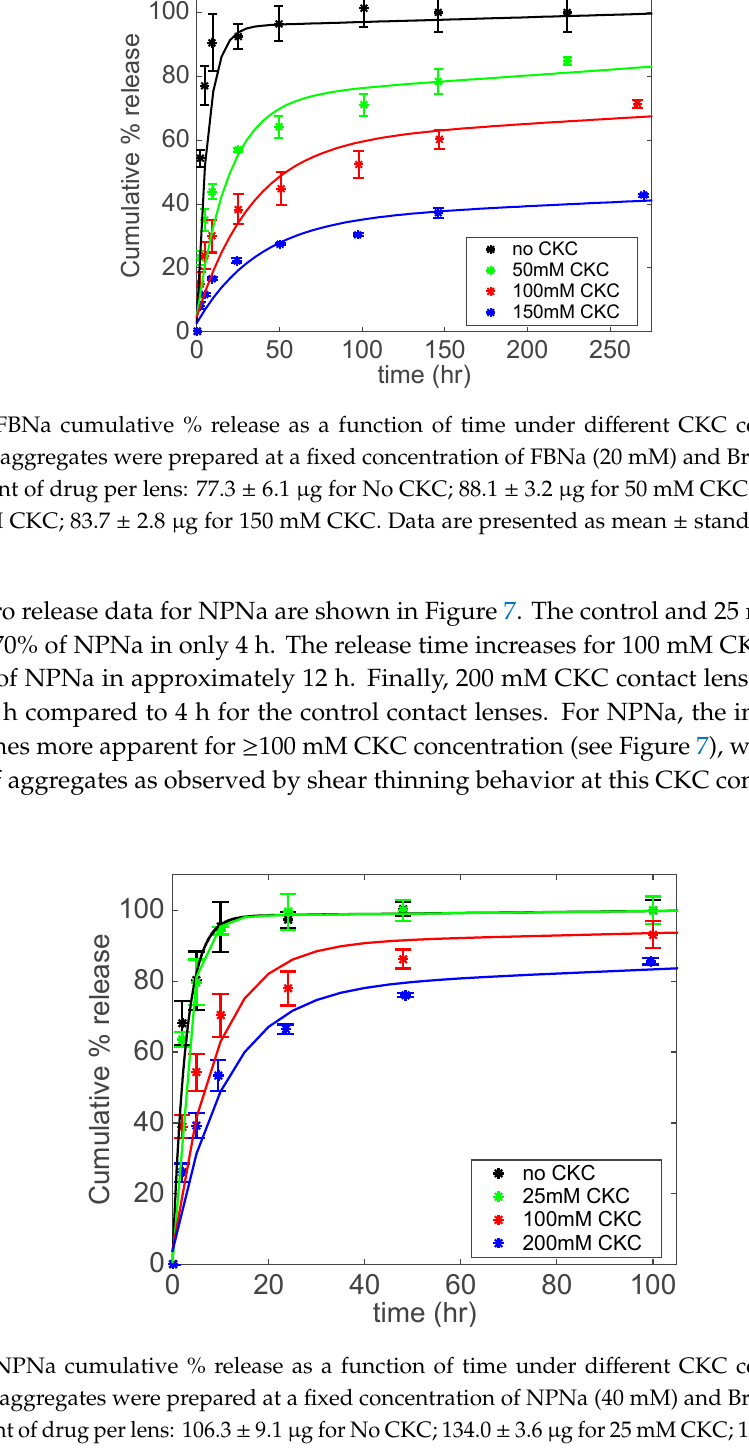
Figure 7. NPNa cumulative % release as a function of time under different CKC concentrations. Catanionic aggregates were prepared at a fixed concentration of NPNa (40 mM) and Brij 97 (20 wt%). Total amount of drug per lens: 106.3 ± 9.1 µg for No CKC; 134.0 ± 3.6 µg for 25 mM CKC; 141.7 ± 14.4 µg for 100 mM CKC; 130.0 ± 8.7 µg for 200 mM CKC. Data are presented as mean ± standard deviation with n = 3.